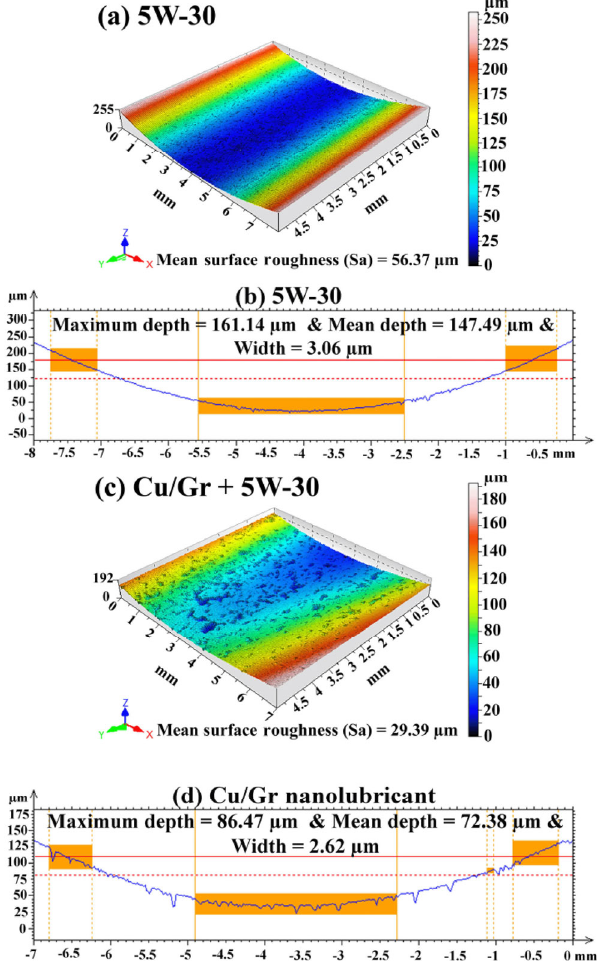
Fig. 10 3D surface roughness of the cylinder liner lubricated by (a, b) reference oil and (c, d) Cu/Gr